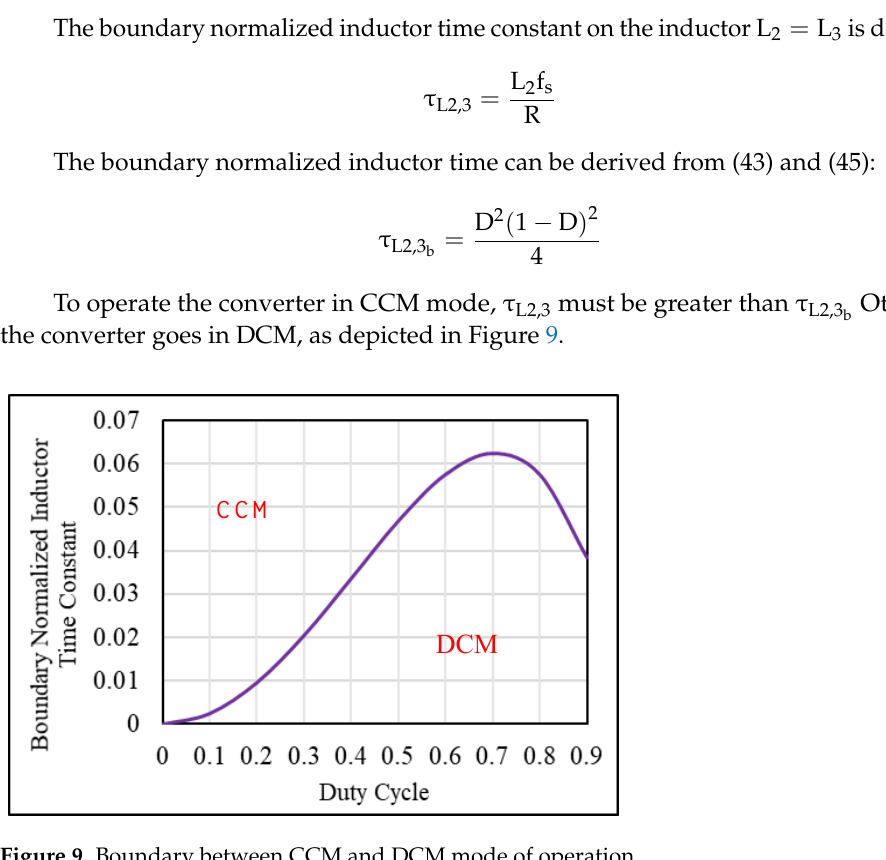
Figure 9. Boundary between CCM and DCM mode of operation.